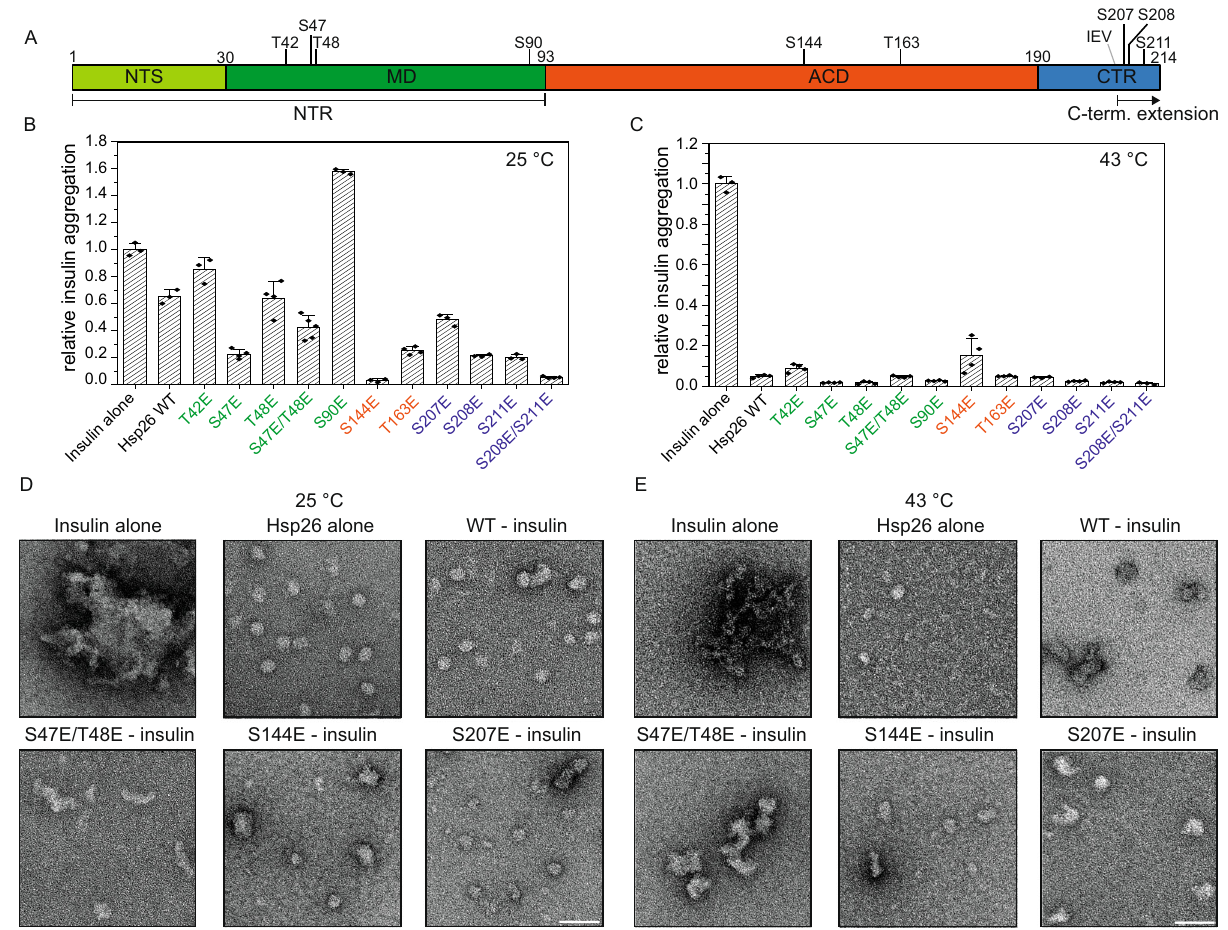
Fig. 1 Phospho-mimetic mutants tend to be more active at room temperature. A Schematic structure of Hsp26 with highlighted phosphorylation sites. B Endpoints of insulin assays performed at 25°C with 40 µ M insulin and 8 µ M chaperone concentration are plotted. Data are presented as mean values + / − SD. Single measurement points are indicated in the plot. Aggregation of insulin was induced by the addition of 20mM DTT. The assay was performed in PBS for 70min. The light scattering signal (360nm) was normalized on the saturation value of the model substrate without chaperone. N = 3 independent experiments for insulin alone, WT, T42E, S90E, S207E, S208E, and S211E; N = 4 for S47E, T48E, S144E, T163E, S208E/S211E; N = 5 for S47E/T48E. C Endpoints of insulin assays performed at 43°C with 45 µ M insulin and 2 µ M chaperone concentration are plotted. Data are presented as mean values + / − SD. Single measurement points are indicated in the plot. The assay was performed in 40mM HEPES/KOH pH 7.5 for 36min. The light scattering signal (360nm) was normalized on the saturation value of the model substrate without chaperone. N = 3 independent experiments for insulin alone, S207E, and S208E/S311E; n = 4 for all remaining samples. More detailed titrations are shown in Fig. S1. D The aggregation assay was performed as described in B . For the visualization of chaperone substrate complexes, samples were taken after 20min and analyzed with TEM at a magni fi cation of 60,000. The scale bar represents 50nm. E The aggregation assay was performed as described in C . For the visualization of chaperone substrate complexes, samples were taken after 20min and analyzed with TEM at a magni fi cation of 60,000. The scale bar represents